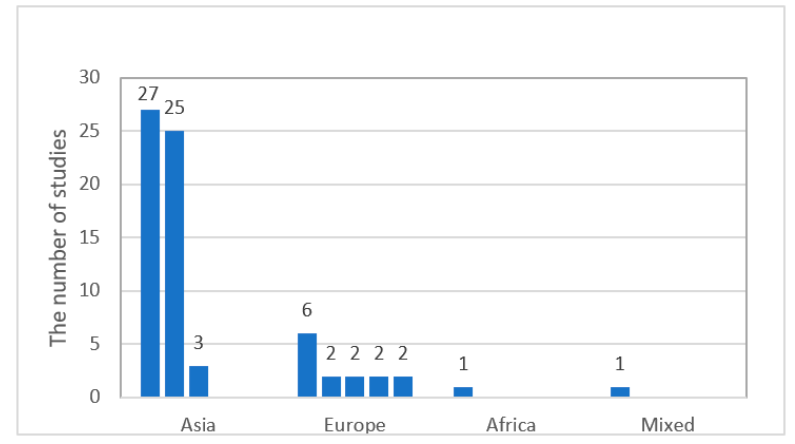
Figure 3. Geographical distribution.